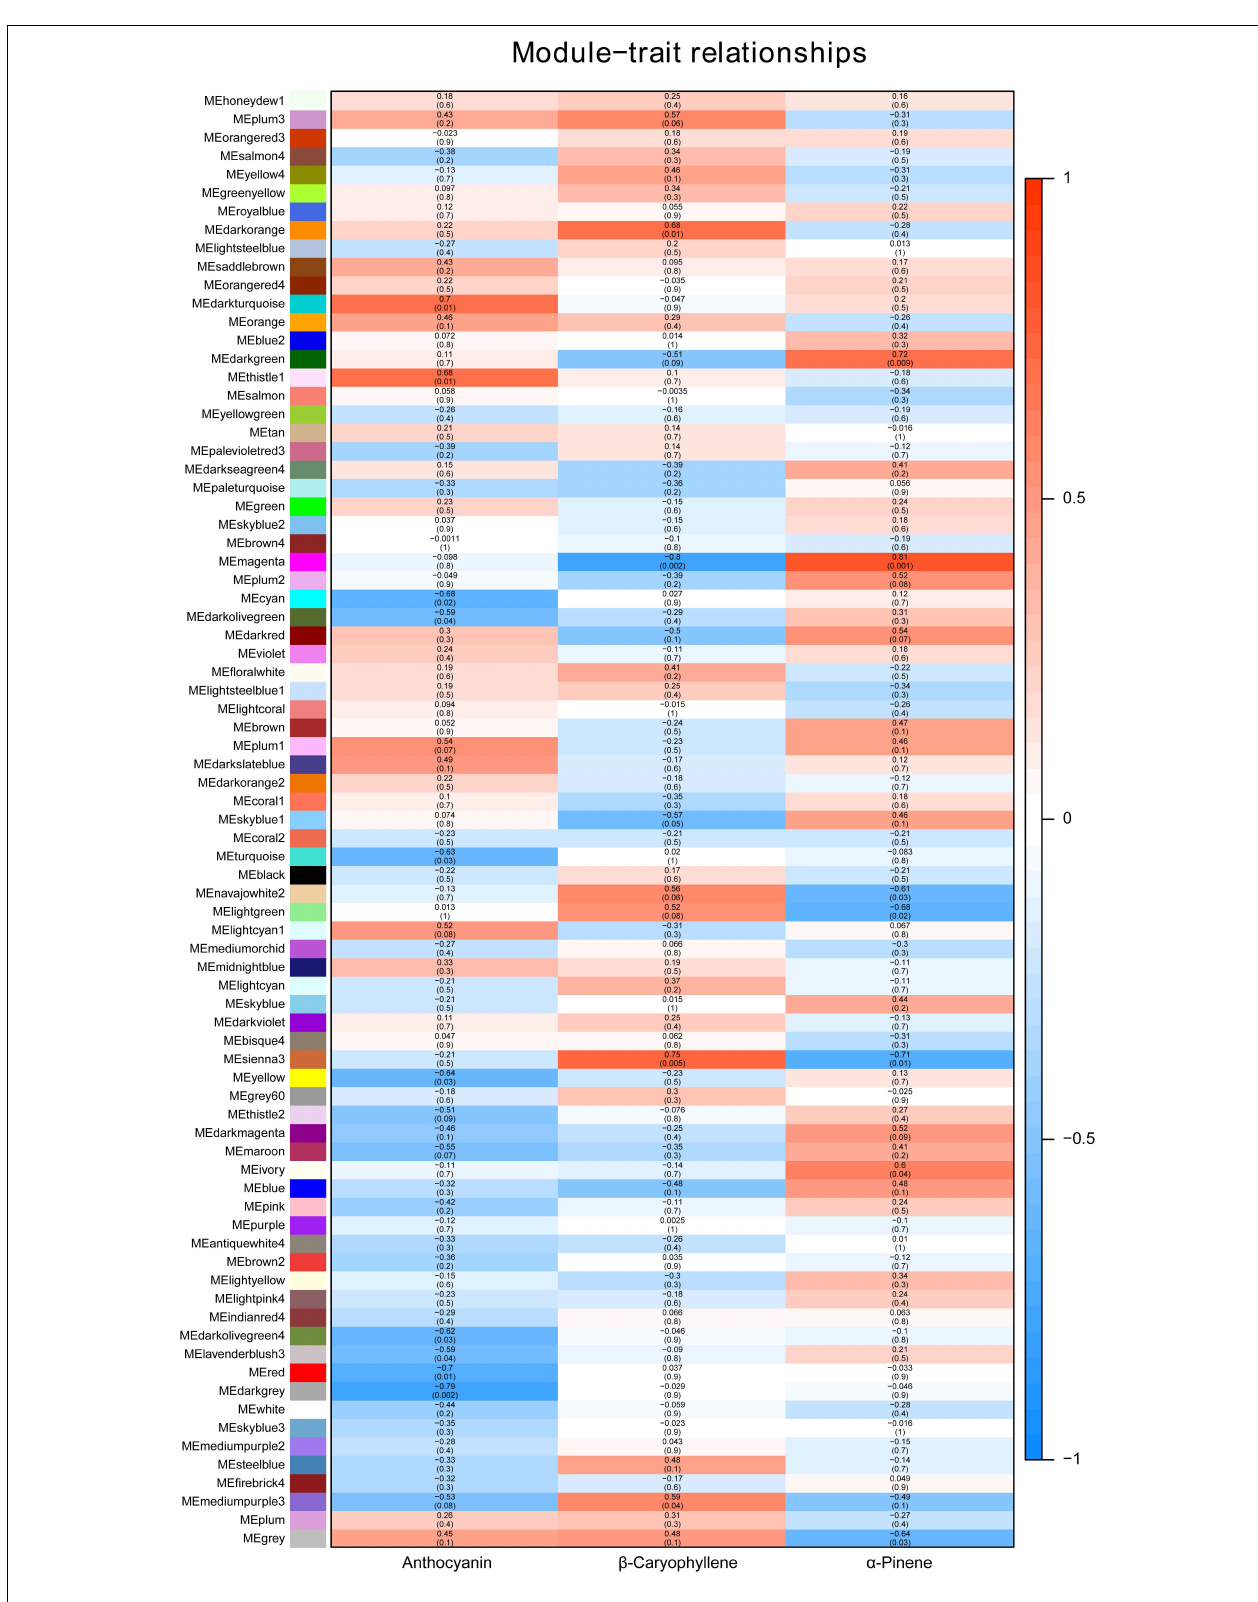
FIGURE 3 | Module-trait relationship of WGCNA. Seventy-eight different modules were grouped for all expressed genes. Colors and numbers indicate the correlation coefficient between gene expressions and compound contents. Numbers in the brackets show the p -values of the significance.